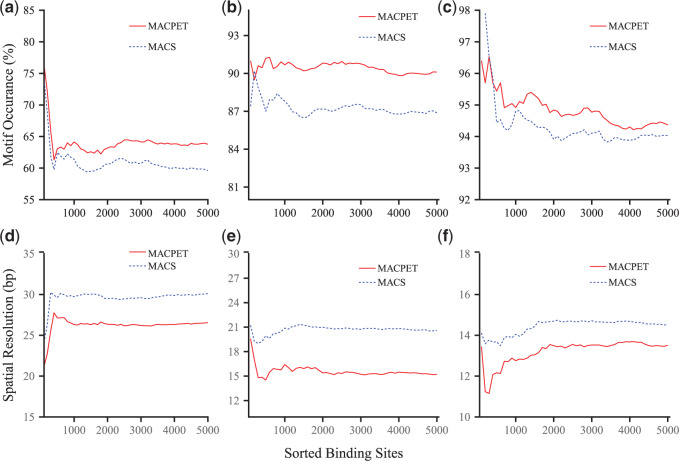

De novo motif discovery. Comparison of motif discovery and spatial resolution between MACPET and MACS. The x-axis for all plots is the top \documentclass[12pt]{minimal}
\usepackage{amsmath}
\usepackage{wasysym}
\usepackage{amsfonts}
\usepackage{amssymb}
\usepackage{amsbsy}
\usepackage{upgreek}
\usepackage{mathrsfs}
\setlength{\oddsidemargin}{-69pt}
\begin{document}
}{}$5000$\end{document} PBSs, sorted by significance in descending order for each method respectively. (a–c) Motif occurrence (y-axis) for (a) ESR1 (MCF-7), (b) CTCF (MCF-7), (c) CTCF (K562). (d–f) Spatial resolution (y-axis) for (d) ESR1 (MCF-7), (e) CTCF (MCF-7), (f) CTCF (K562).